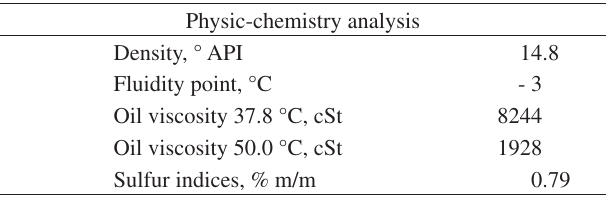
Table 1. Heavy crude oil physic-chemistry analysis.